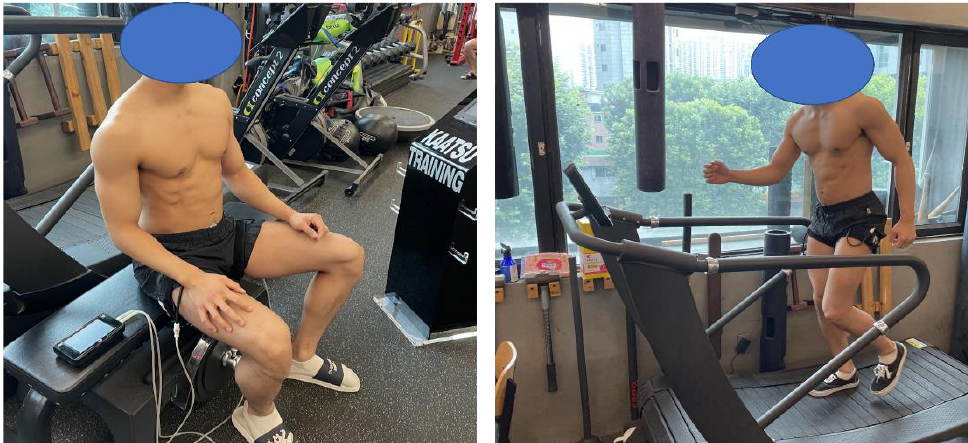
Figure 1. Occlusion cuff belts used in this study for blood flow restriction.